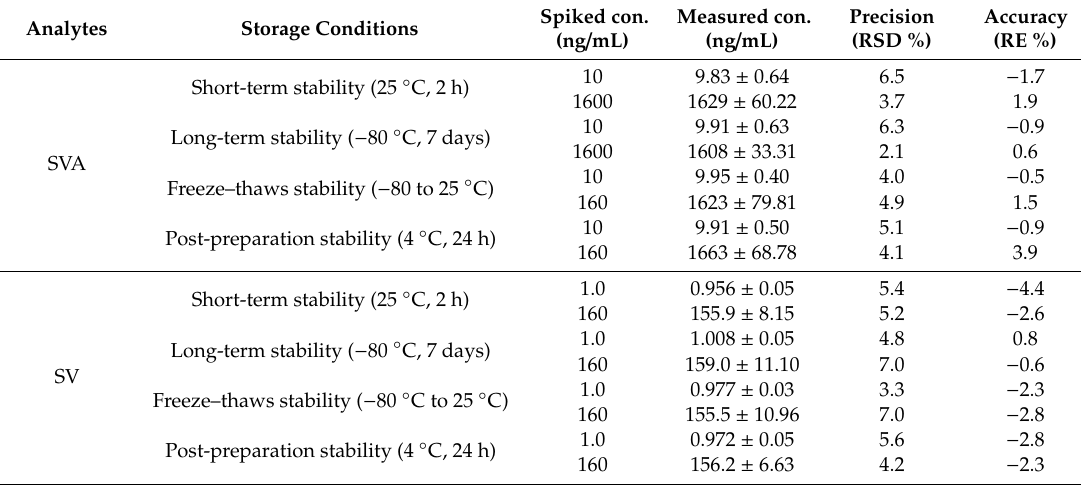
Spiked con. Measured con. Precision Accuracy (ng/mL) (ng/mL) (RSD %) (RE %)